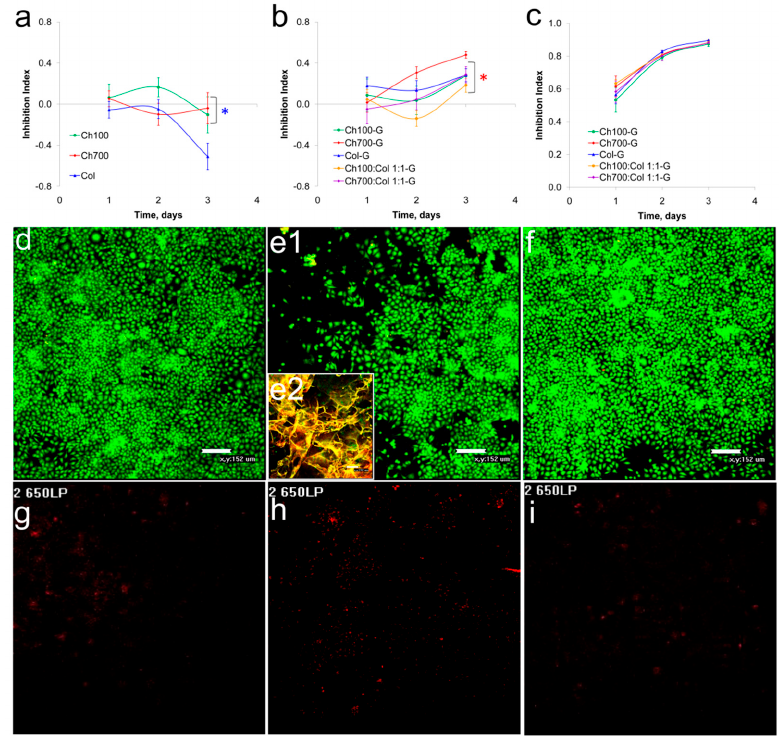
Figure 1. Gels cytotoxicity. ( a – c ): Cytotoxicity of uncrosslinked gels ( a ) and gels crosslinked with 0.03% ( b ) and a 0.3% solution of genipin ( c ) on EAhy 926 cell lines. ( d – i ) Cells were incubated for 72 h without ( d , g ) or with Ch700-G ( e , f , h , i ) and stained with acridine orange ( d – f , green) and propid- ium iodide ( g – i , red). Insert ( e2 ) shows the place of Ch700-G gel deposition in the well. The statistical significance was evaluated using the Student’s t -test: Blue star corresponds to— p < 0.05 vs. Col, red star—to p < 0.05 vs. Ch700-G.